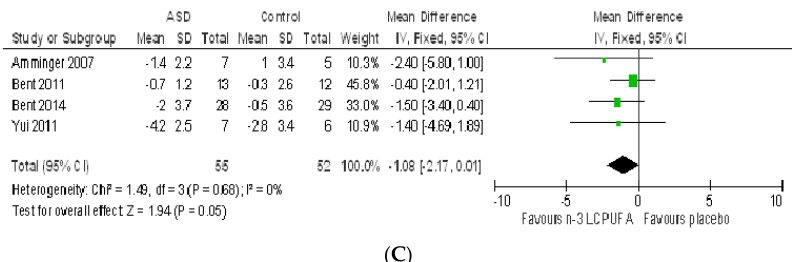
Figure 6. Forest plot of mean (95% confidence interval (CI)) fixed difference in change in social interaction (ABC) ( A ); communication (ABC) ( B ); and repetitive and restricted interests and behaviours (ABC) ( C ) in populations with Autism Spectrum Disorder (ASD) receiving n ‐ 3 long chain polyunsaturated fatty acid supplementation (LCPUFA) and placebo. Direction of effect (negative, more improvement in n ‐ 3 LCPUFA groups; positive, more improvement in placebo group; zero, no difference between groups).